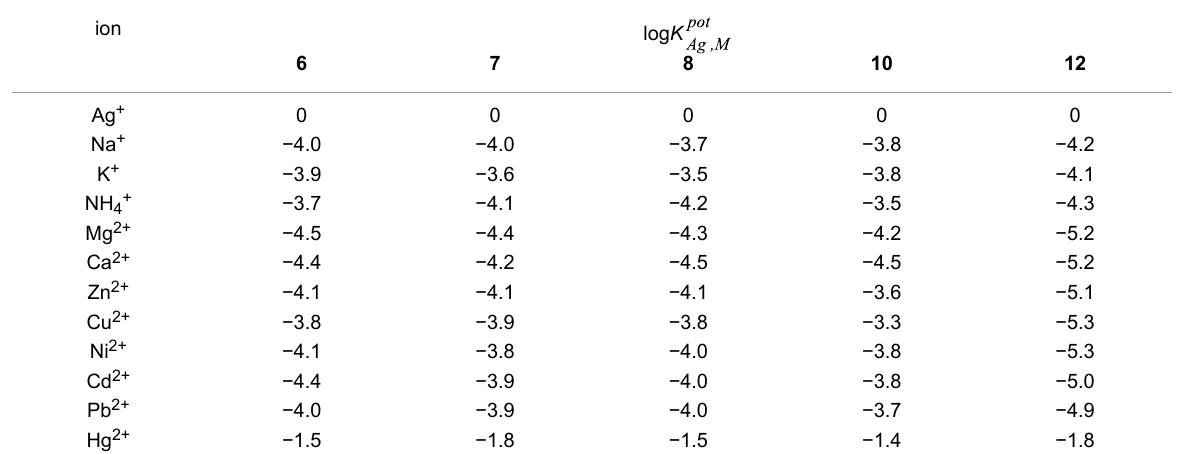
Table 1: Selectivity coefficients (log